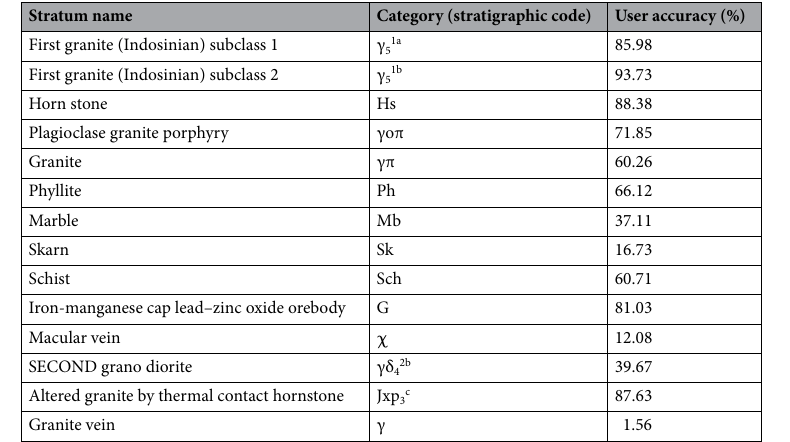
Table 1. accuracy statistics of SAM results (user accuracy).